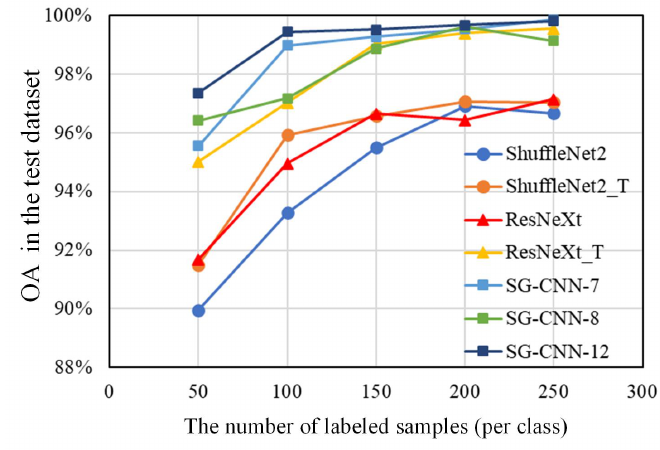
Figure 11. Overall classification accuracies of the test samples based on various methods trained/fine- tuned with 50–250 labeled samples for the Houston 2013 scene.